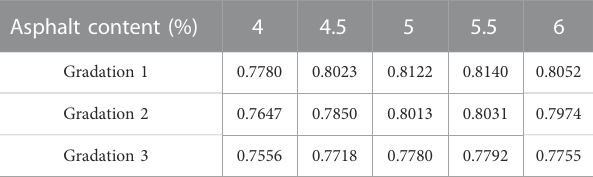
TABLE 15 ctual accumulation of the gradations for different asphalt contents. Asphalt content (%)